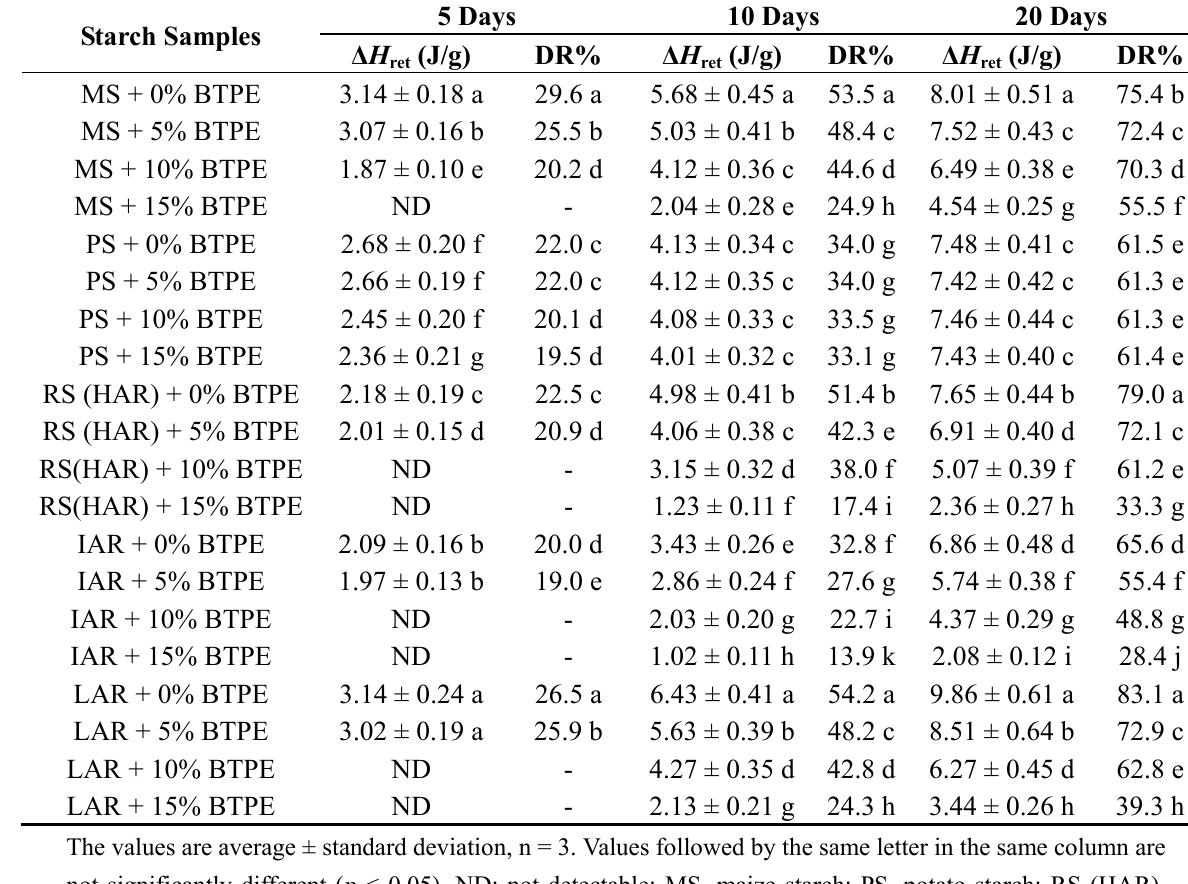
Table 4. The enthalpy and degree of retrogradation of mixtures of different starch samples and black tea polyphenol extract (BTPE) at various ratios after 4 °C